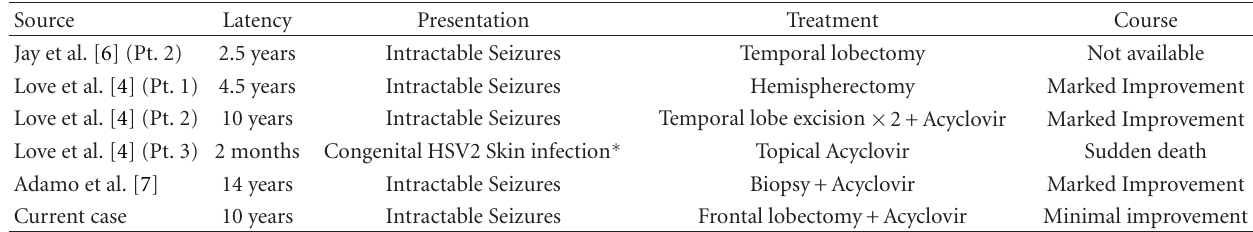
Table 1: Histologically verified cases of chronic granulomatous herpes simplex encephalitis. Source